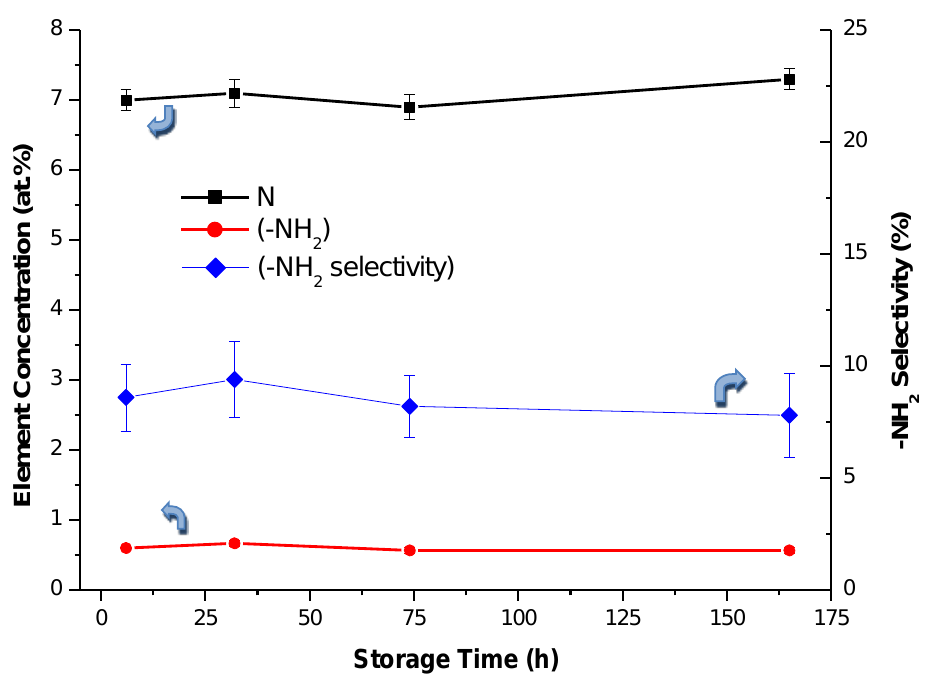
Figure 5. Time-evolution of the surface-compositions of treated pressed CNTs pellets with storage time under ambient